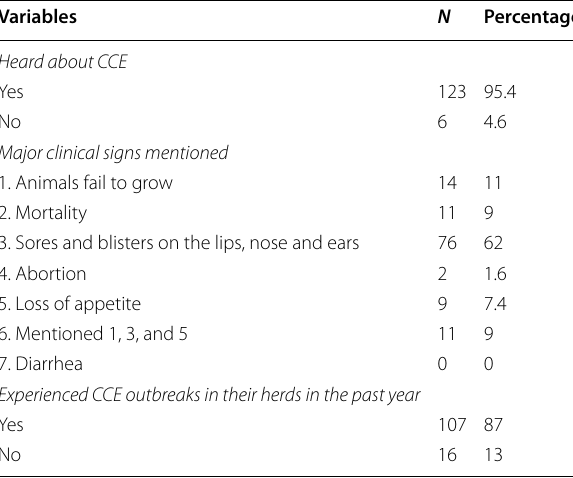
Table 2 Selected variables of herders’ knowledge on